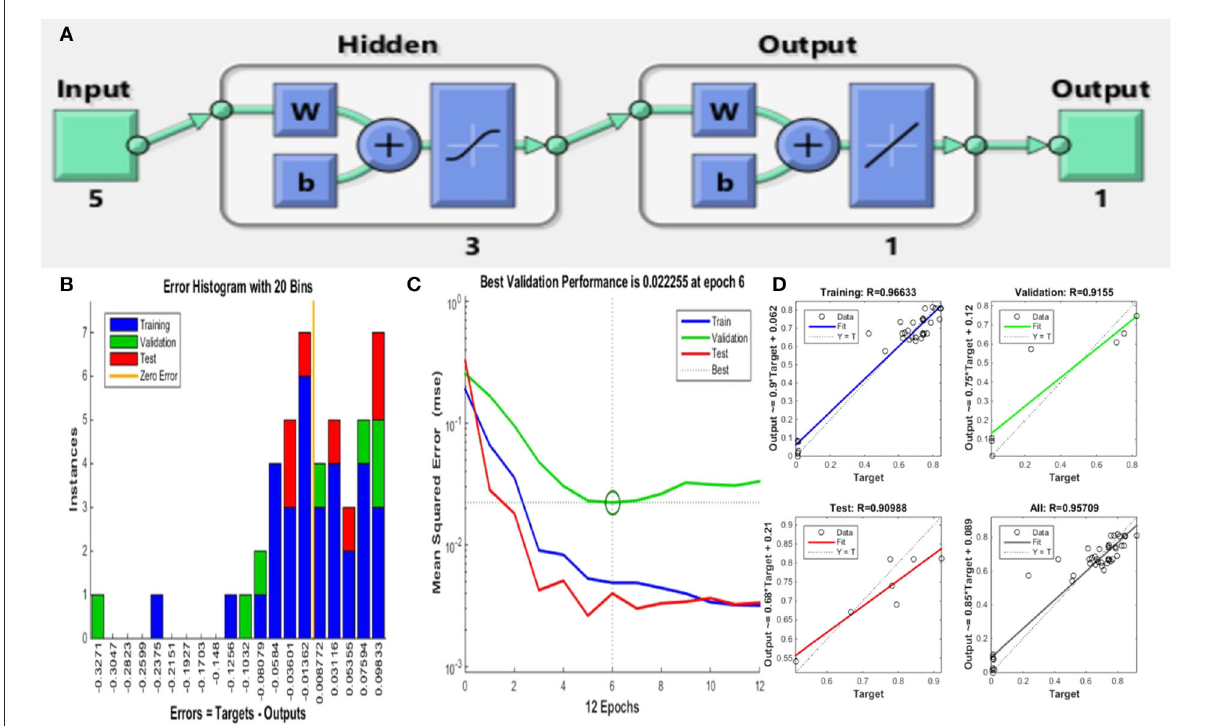
FIGURE3 ANN-TLBO approach for ZnO NP synthesis. (A) Model architecture, (B) error histogram of the proposed model, (C) performance plot of the proposed model, and (D) regression plot for training, testing, and